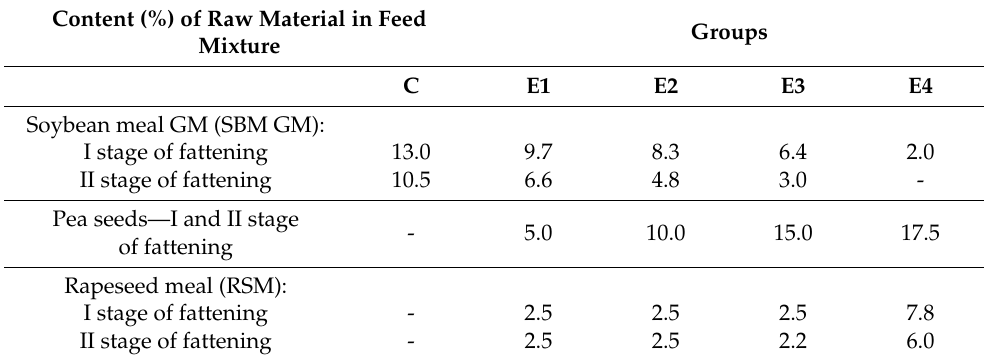
Table 1. Experiment design.